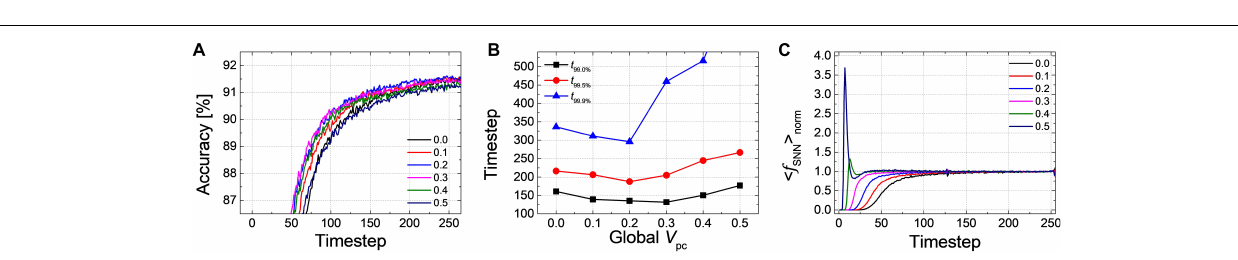
FIGURE 5 | (A) Accuracy-timestep result for Net 2 with the global V pc changing from 0.0 to 0.5 with 0.1 steps. (B) Extracted timestep to reach 99.0, 99.5, and 99.9% of the ANN’s accuracy according to the changes of the global V pc . (C) The average firing rate in the output layer with different level of the global V pc according to the simulation timestep. It is noticeable that the point of timestep in which the firing rate rises becomes